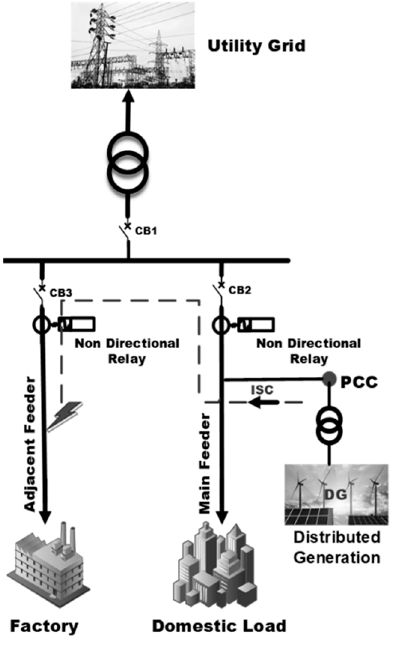
Figure 6. Sympathetic tripping of adjacent feeder in the presence of DG.